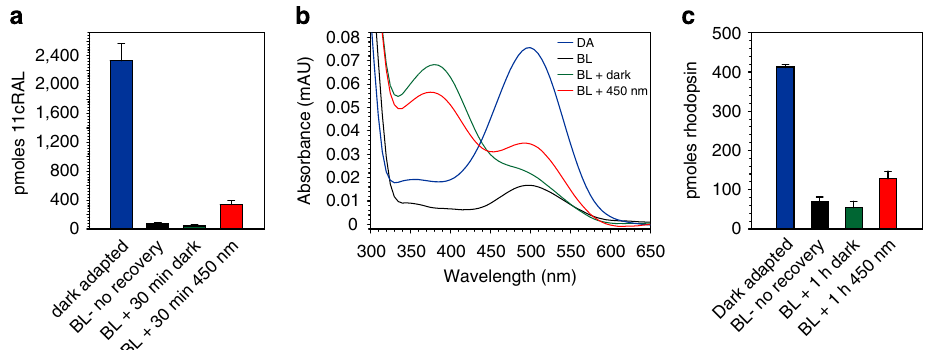
Fig. 2 Light-dependent regeneration of 11cRAL and rhodopsin in bovine OS. Aliquots of rod OS from dark-adapted bovine retinas were analyzed before and after a deep photobleach. After addition of atRAL, the remaining aliquots were incubated in the dark or in 450-nm light at 0.5 W/m 2 for the indicated times. a Levels of 11cRAL in dark-adapted (DA), immediate post-bleach (BL — no recovery), post-bleach plus 30 min incubation with atRAL in the dark (BL + 30 min dark), or post-bleach plus 30 min incubation with atRAL in 450-nm light (BL + 30 min 450 nm) OS. Data are plotted as mean ± s.d. ( n = 3). b Representative UV-visible spectra of af fi nity-puri fi ed rhodopsin from bovine OS treated as described in panel c . The prominent 360-370-nm shoulders in the rhodopsin spectra from the (BL + 1 h dark) and (BL + 1 h. 450 nm) samples represent the added atRAL. c Levels of rhodopsin in bovine OS from dark-adapted bovine eyes (DA), immediately following a photobleach (BL - no recovery), incubated for 1 h in the dark with atRAL following the photobleach (BL + 1 h dark), or incubated for 1 h in 450-nm light with atRAL following the photobleach (BL + 1 h 450 nm). Data are plotted as mean ± s.d. ( n = 3) Table 1 Retinaldehydes in N-ret-PE and total retinaldehydes in DA mouse retinas (pmoles per retina) 11cRAL atRAL Retinaldehydes in N-